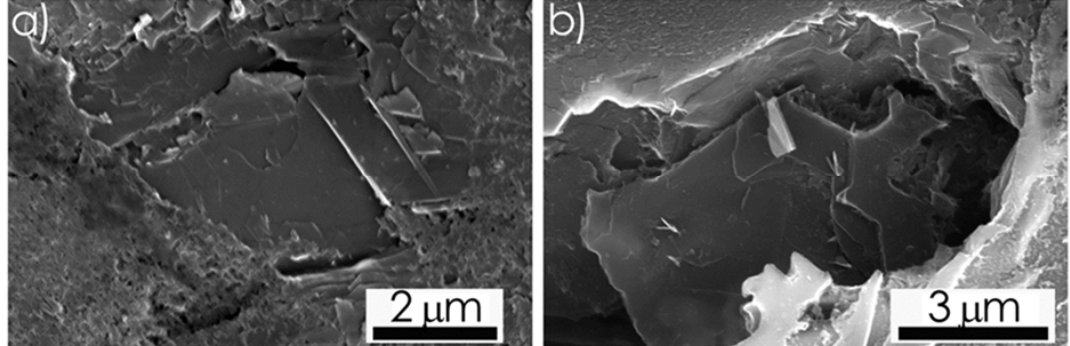
Figure 5. Initial stage of internal destruction of graphite spheroid, SEM: ( a ) The central disgregation with shifted graphene plates (SGP) at a distance of 3 mm from the fracture surface, specimen SNi11, ( b ) a local shift of the graphene plates (SGP) at G-M interface, at a distance of 1 mm from fracture surface, specimen ADI390 (SGP).